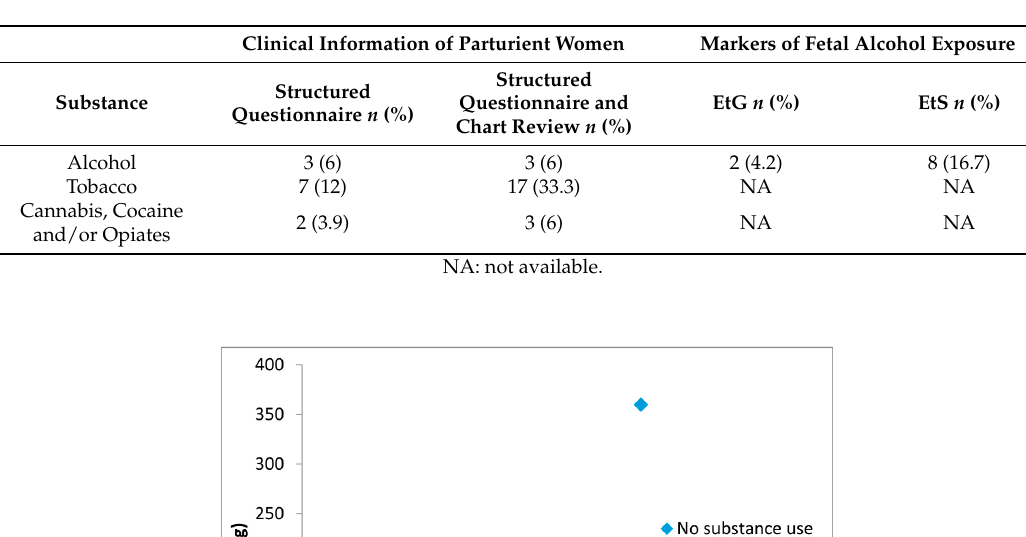
Table 1. Prevalence of substance use during pregnancy according to clinical data of parturient women and markers of fetal alcohol exposure.